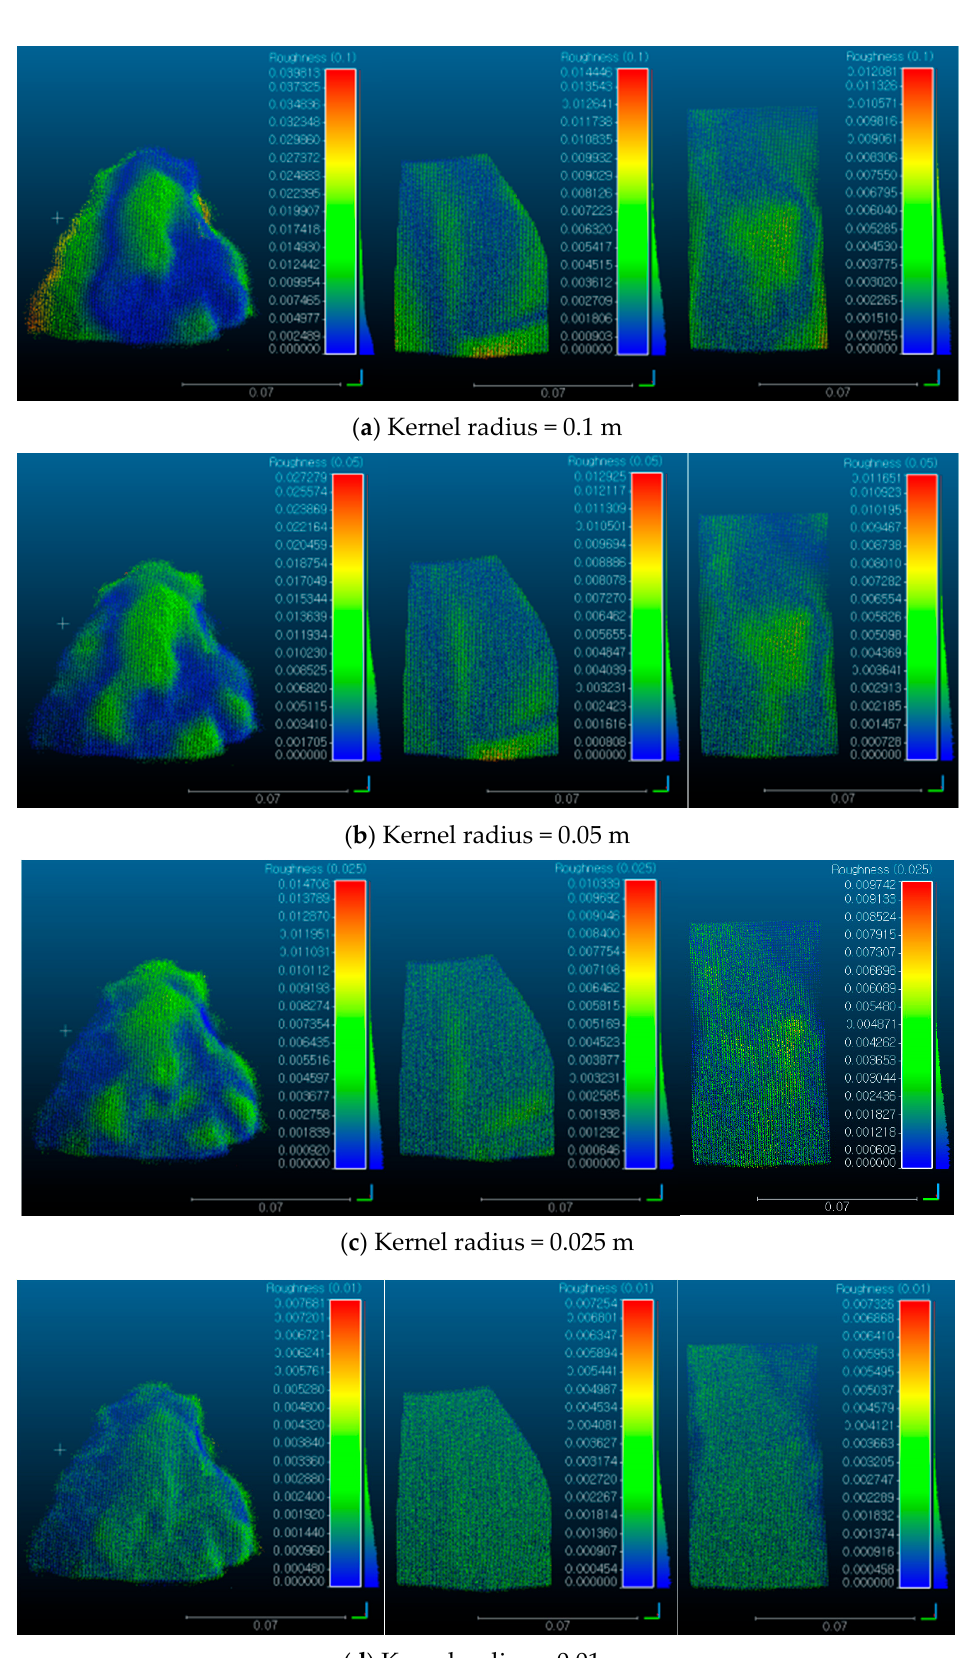
Figure 12. Color scale indicating the degree of roughness of the cloud.